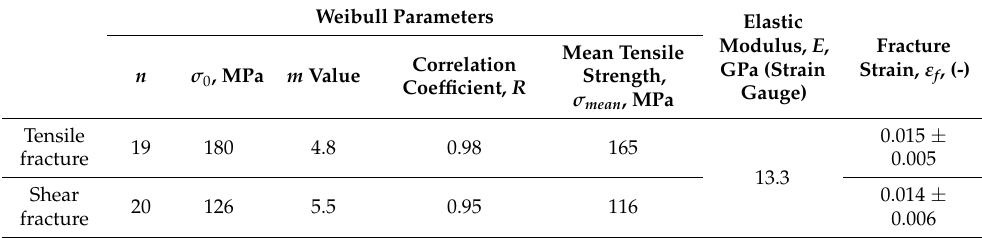
Figure 9. Weibull analysis plots corresponding to the two failure modes. Table 1. Weibull parameters, elastic modulus, E , and fracture strain, ε f , determined by tensile examination in the present study.